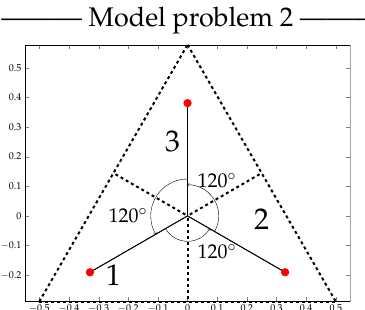
Figure 7. Sequence of points on a unit element for model problem 1 and 2.